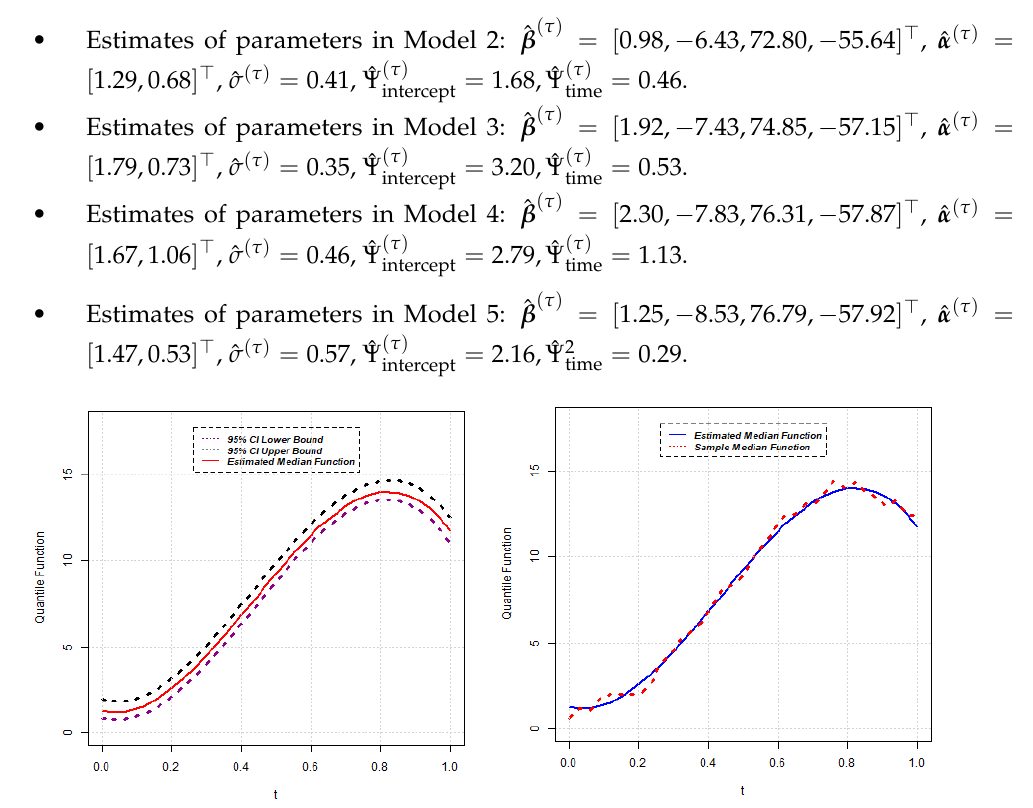
Figure 6. Estimated median function and C.I. ( left ); Estimated median and sample median ( right ) for Model 1.